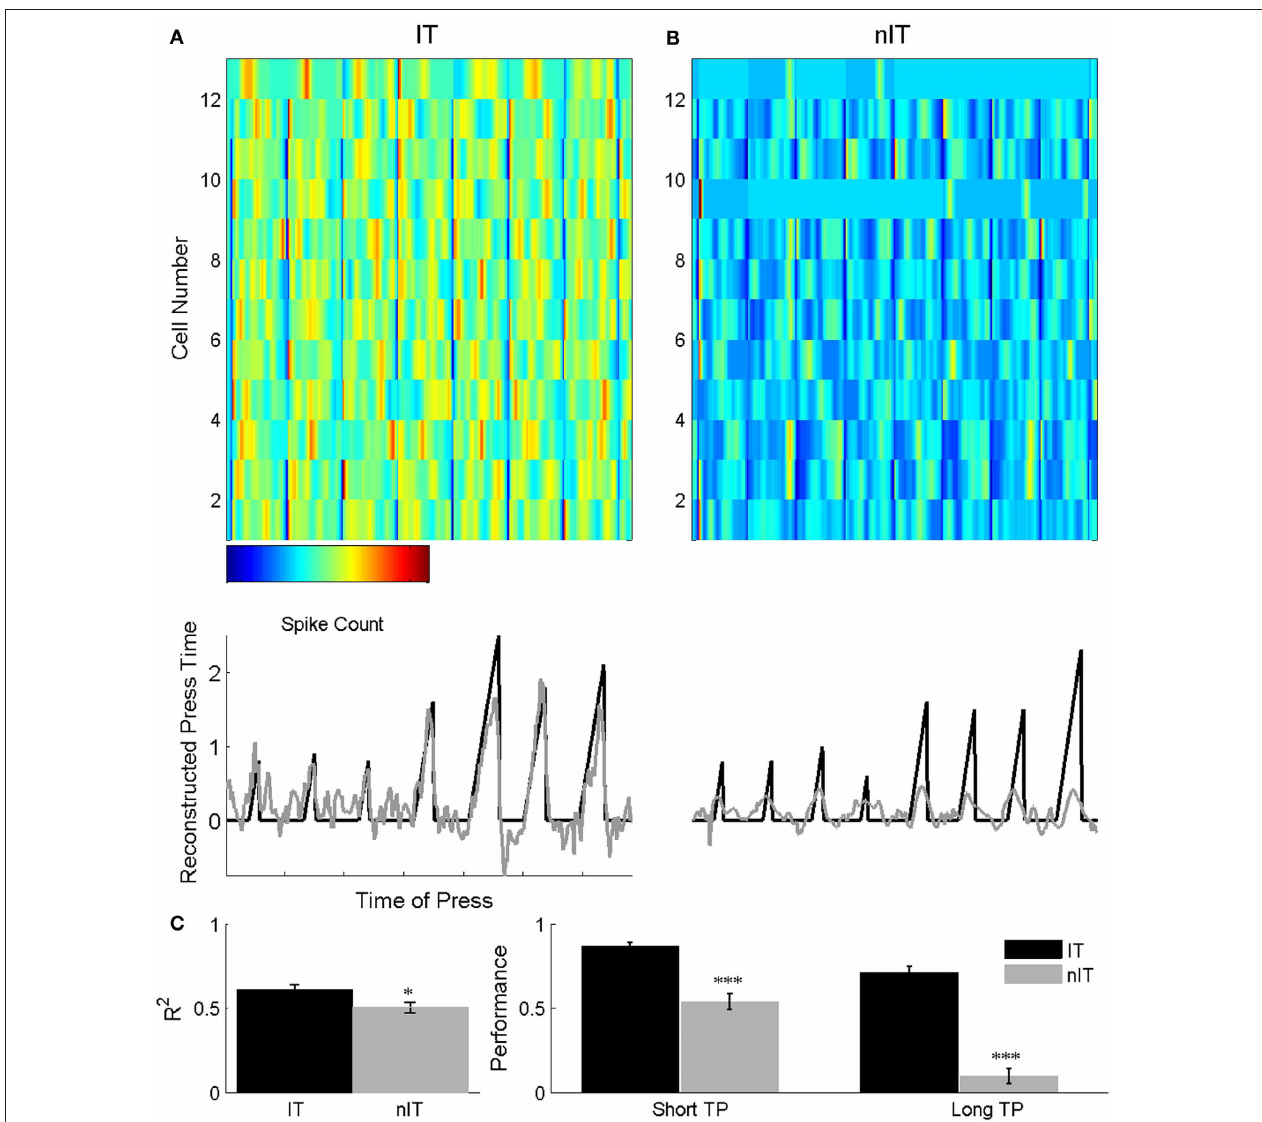
FIGURE 6 | Example ensemble activity (A, B top) used to reconstruct press duration (bottom) for an IT (A) and an nIT (B) animal. IT neurons are clearly modulated throughout short ( A , left of panel) and long ( A , right of panel) duration presses, while nIT neurons appear strongly modulated around the start and end of press, but not throughout the press period. In the reconstructions (middle), solid black lines are actual press durations and gray lines are predicted durations from the ensemble activity. IT ensemble activity faithfully reproduces